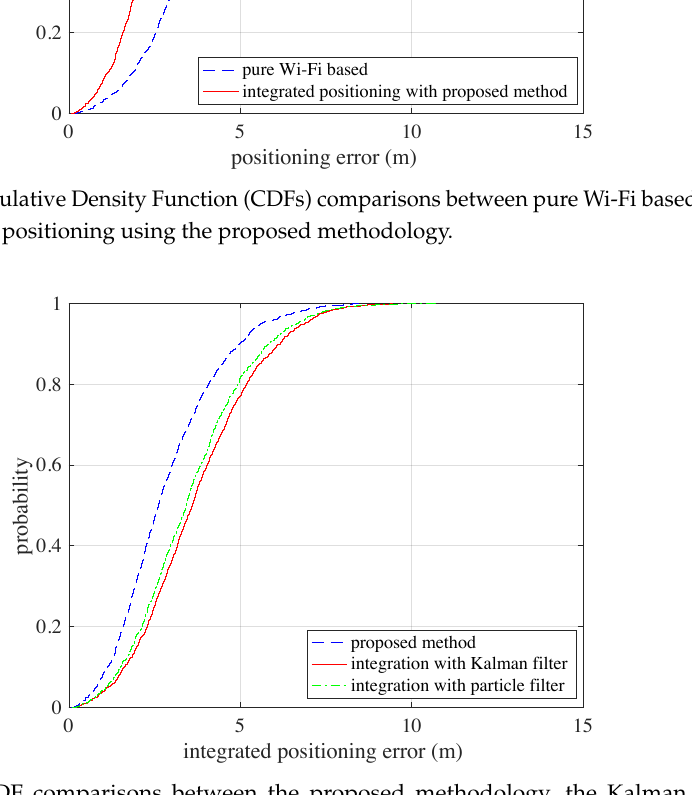
Figure 9. The CDF comparisons between the proposed methodology, the Kalman filter based methodology and the particle filter based methodology.